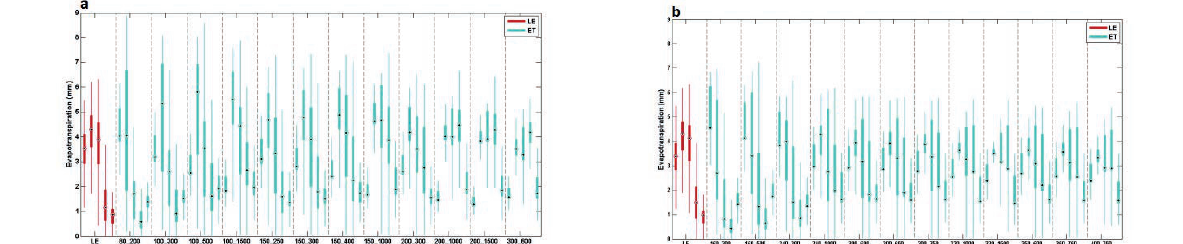
Fig. 2 Daily evapotranspiration at five dates (in mm, including both LE and ET, with five days each group) in (a) deciduous forest and (b) pine forest. The red boxplots are one LE group as well as the 12 green boxplot groups from ET groups simulated with 12 different surface resistance combinations by WaSiM-ETH. The five sample dates are 15 May 2000, 5 July 2001, and 19 July, 4 August and 21 September 2003, in order.